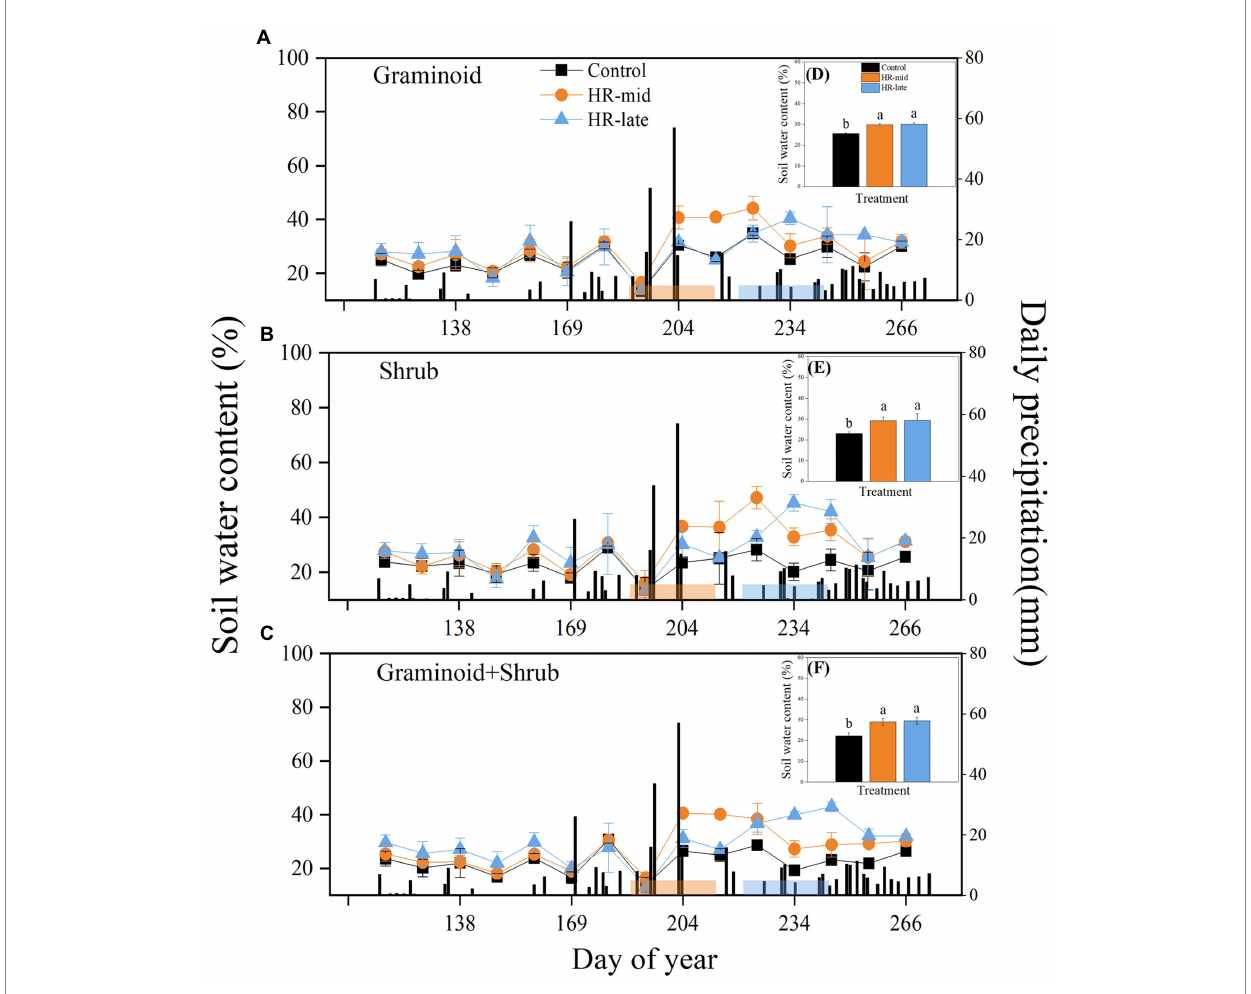
FIGURE 1 Seasonal dynamic and mean of soil water content under heavy rainfall treatments in graminoid (A,D) , shrub (B,E) , and graminoid +shrub (C,F) plots. Different letters above bars in d, e and f indicate significant difference among treatments at p ≤ 0.05. The orange and blue shaded regions in a–c indicate the periods of the HR-mid (heavy rain imposed in middle of the growing season, orange line) and HR-late (heavy rainfall imposed late in the growing season, blue line) treatments, respectively. Error bars show one standard error of the mean.